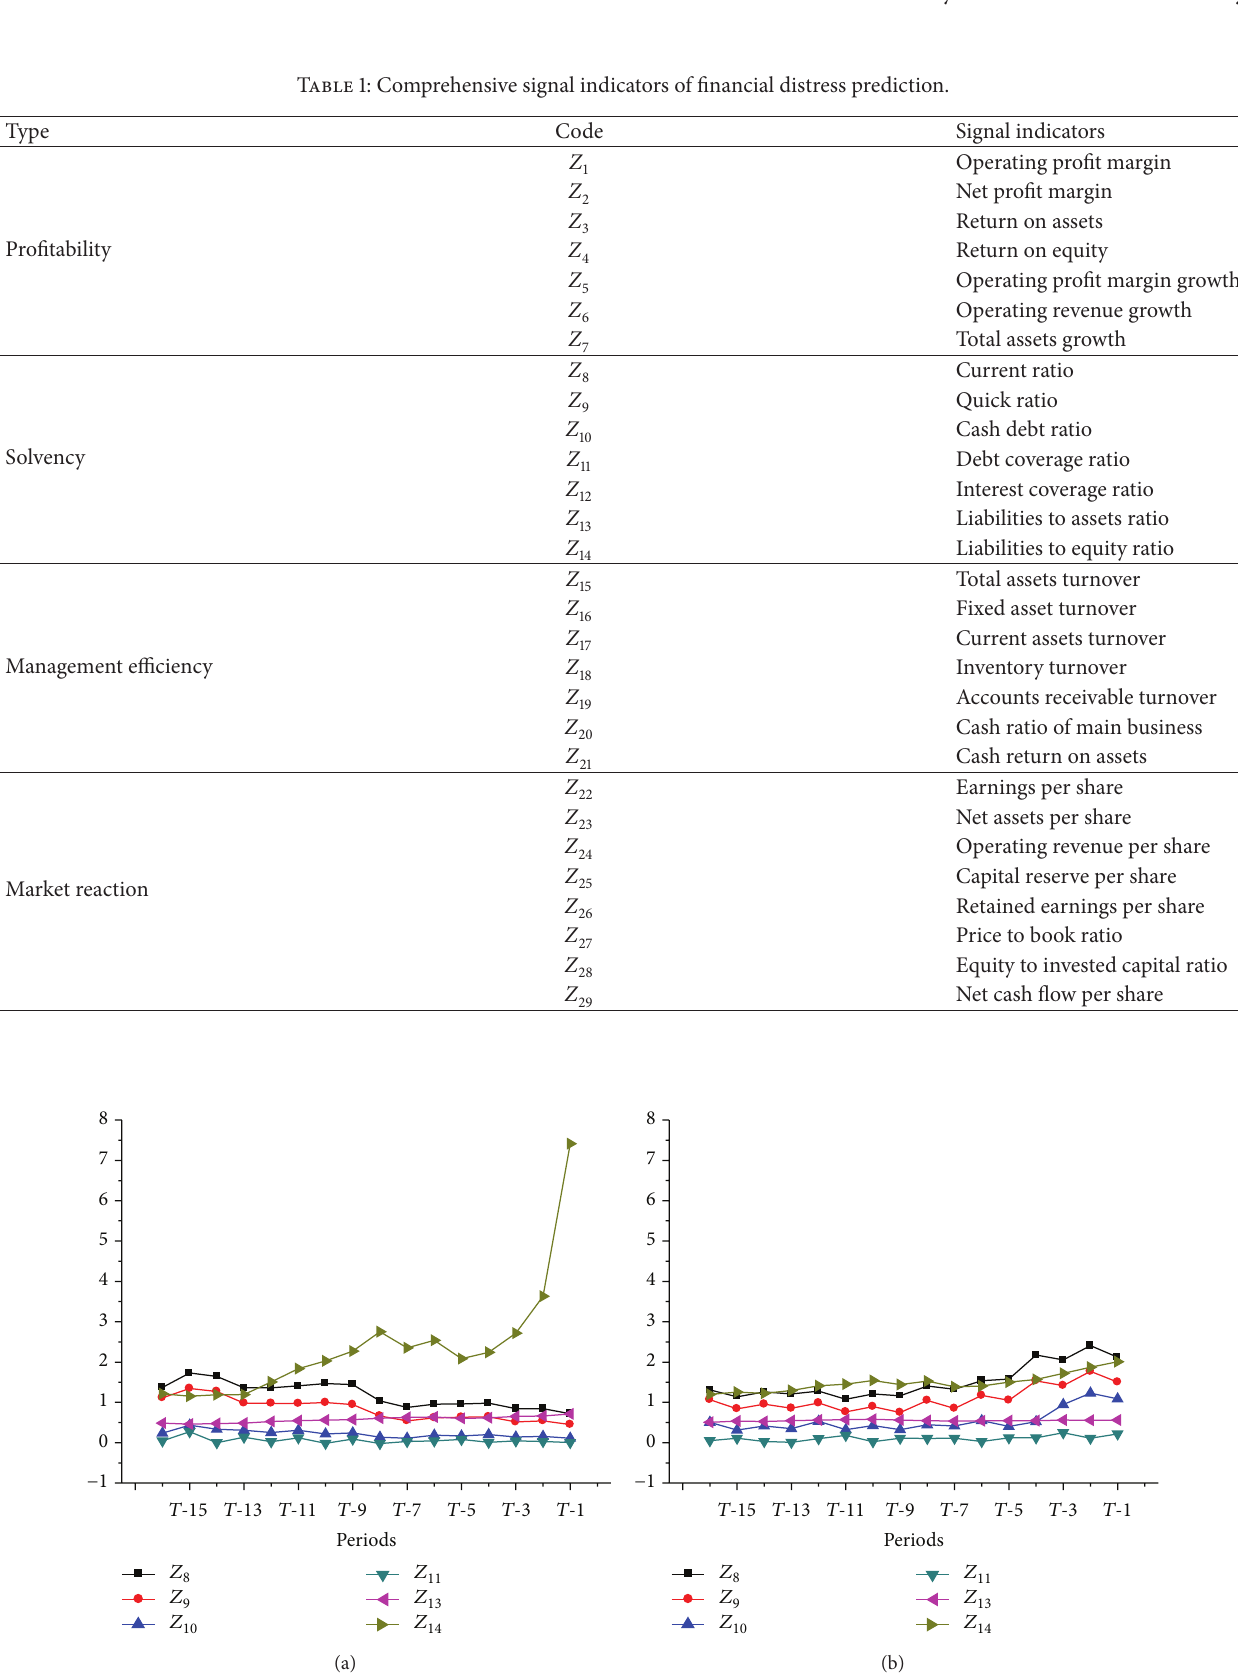
Figure 4: The trend analysis of mean of signal indicators of solvency for distress samples and healthy